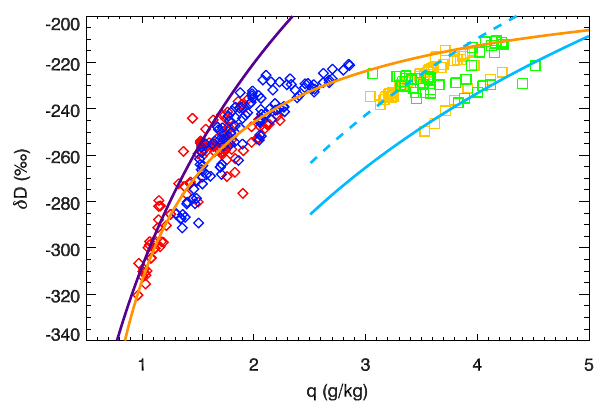
Fig. 5. Joint q − δ D diagram showing tower data from 300 m (red and orange) and the base of the tower (blue and green). Data from the first three days of the experiment are shown as red and blue dia- monds and the data from the final day of the experiment (after 07:00 p.m. MST on 17 February) are shown as orange and green squares. Theoretical curves are placed subjectively to provide context. The purple curve is a saturated Rayleigh curve assuming source vapor is initially at 70% relative humidity over an ocean at 10 ◦ C as might be typical of a North Pacific origin, and the cyan line shows a sat- urated Rayleigh curve assuming the source vapor is saturated over an ocean at 25 ◦ C as is more typical of a Gulf of Mexico origin. The dashed cyan curve has the same origin, but the precipitation effi- ciency is 0.5. The orange line is for mixing between an air mass with q = 0 . 8 gkg − 1 and δ D =− 350‰ and a source with δ D =− 190.